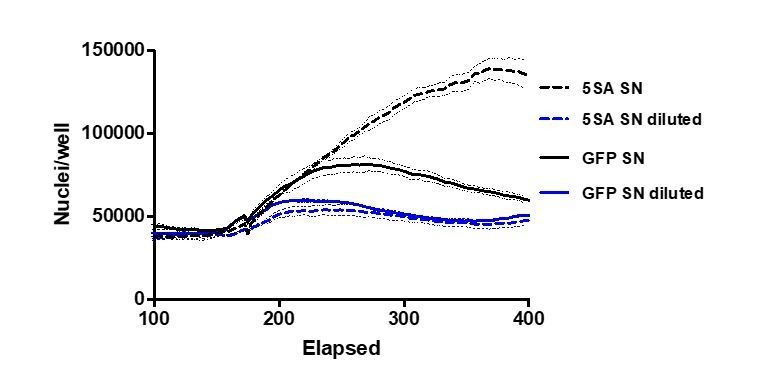
1 pt lines reflect the mean and 0.25 pt lines are ± SEM.